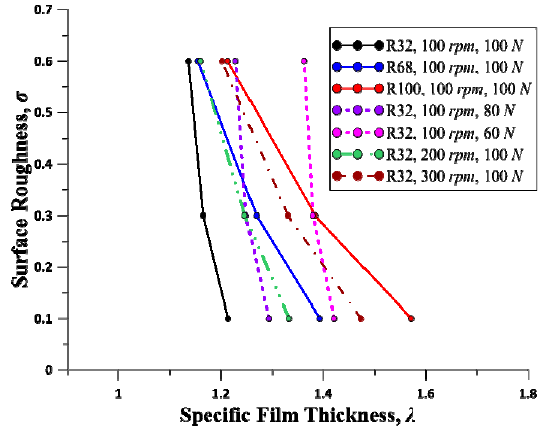
Figure 13. Variation in specific film thickness for different surface roughness under different condition